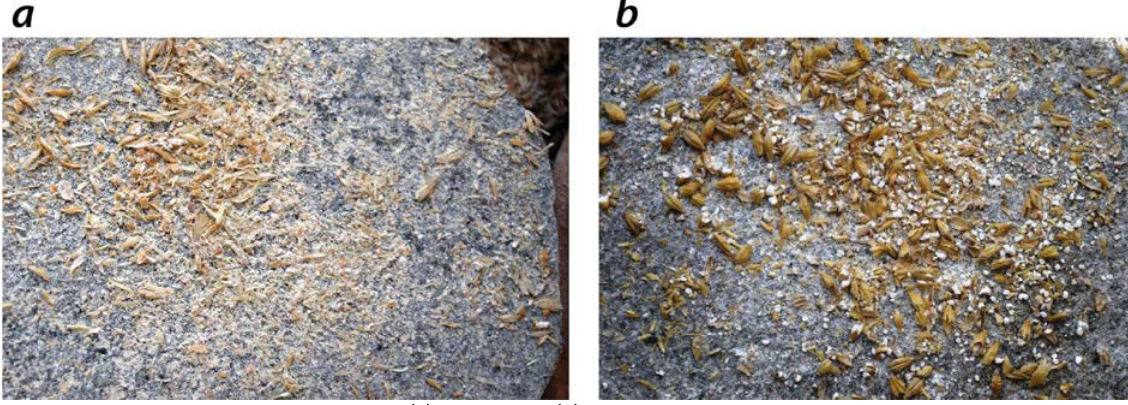
Figure 9. Experimental sequences. Fine (a) and coarse (b)